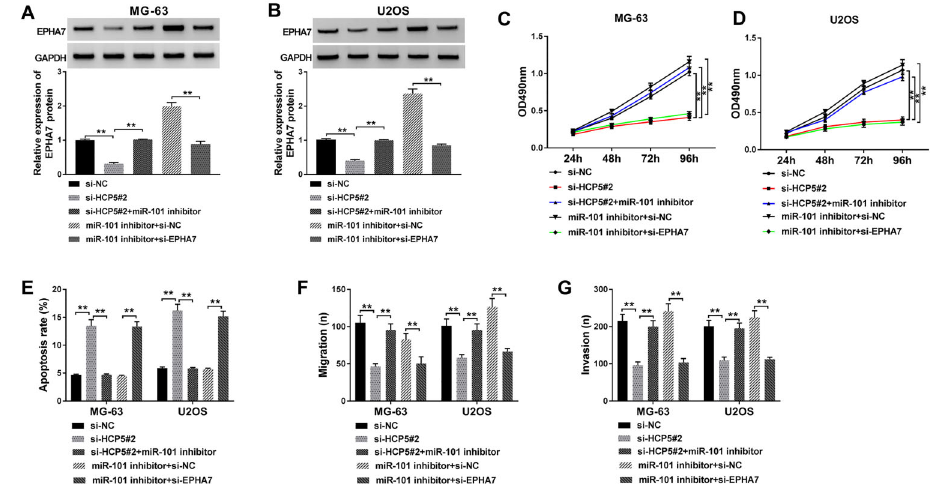
Figure 6. HCP5 regulated cell proliferation, apoptosis, migration, and invasion in osteosarcoma (OS) cells by controlling the expression of EPHA7 via targeting miR-101. A and B , Relative protein expression level of EPHA7 was determined by western blot in MG-63 and U2OS cells transfected with si-NC (negative control), si-HCP5#2, si-HCP5#2 + miR-101 inhibitor, miR-101 inhibitor + si-NC, and miR- 101 inhibitor + si-EPHA7. C and D , Cell proliferation was measured by MTT assay in MG-63 and U2OS cells containing diverse transfection. E , Cell apoptosis was examined using fl ow cytometry. F and G , Cell migration and invasion were detected in MG-63 and U2OS cells after transfection by transwell assay. Data are reported as means ± SD. ** P o 0.01